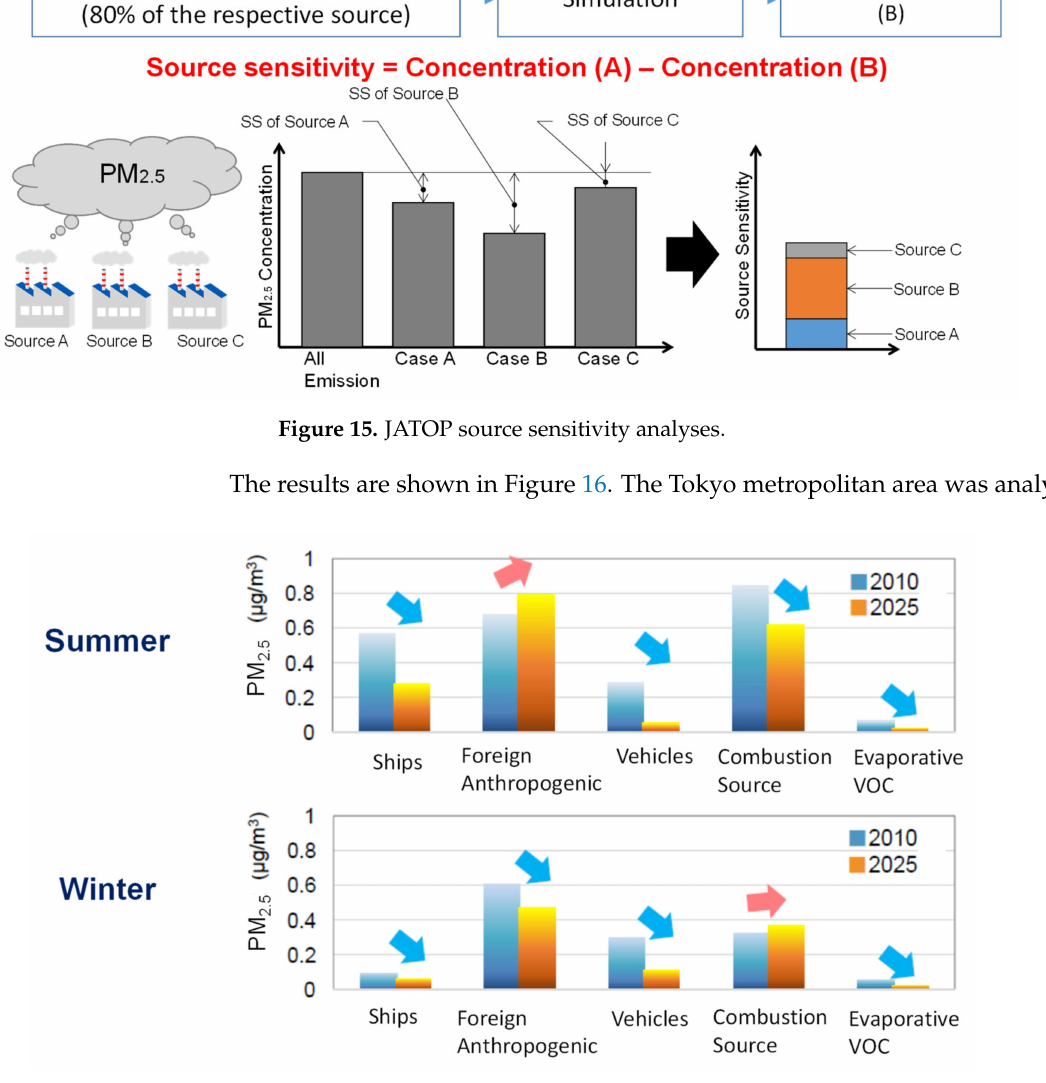
Figure 16. Source sensitivity analysis results